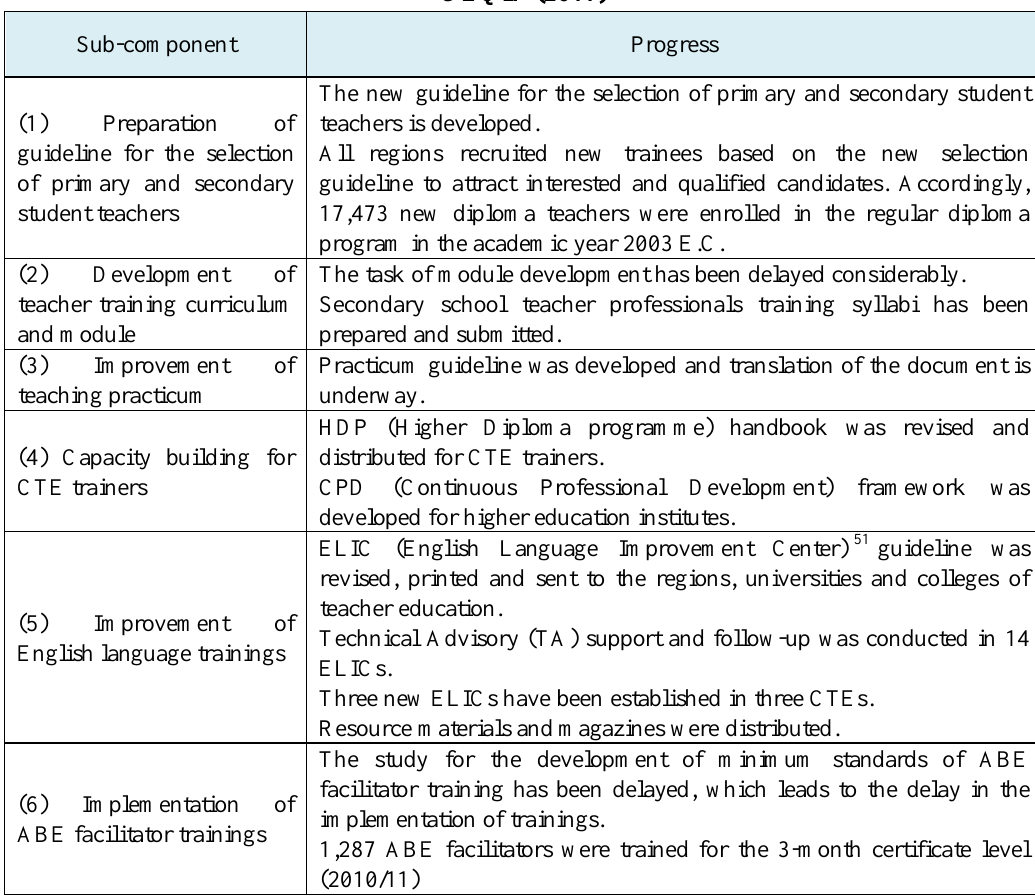
Table 4-15: Progress in the Teachers Development Programme Sub-components of GEQIP